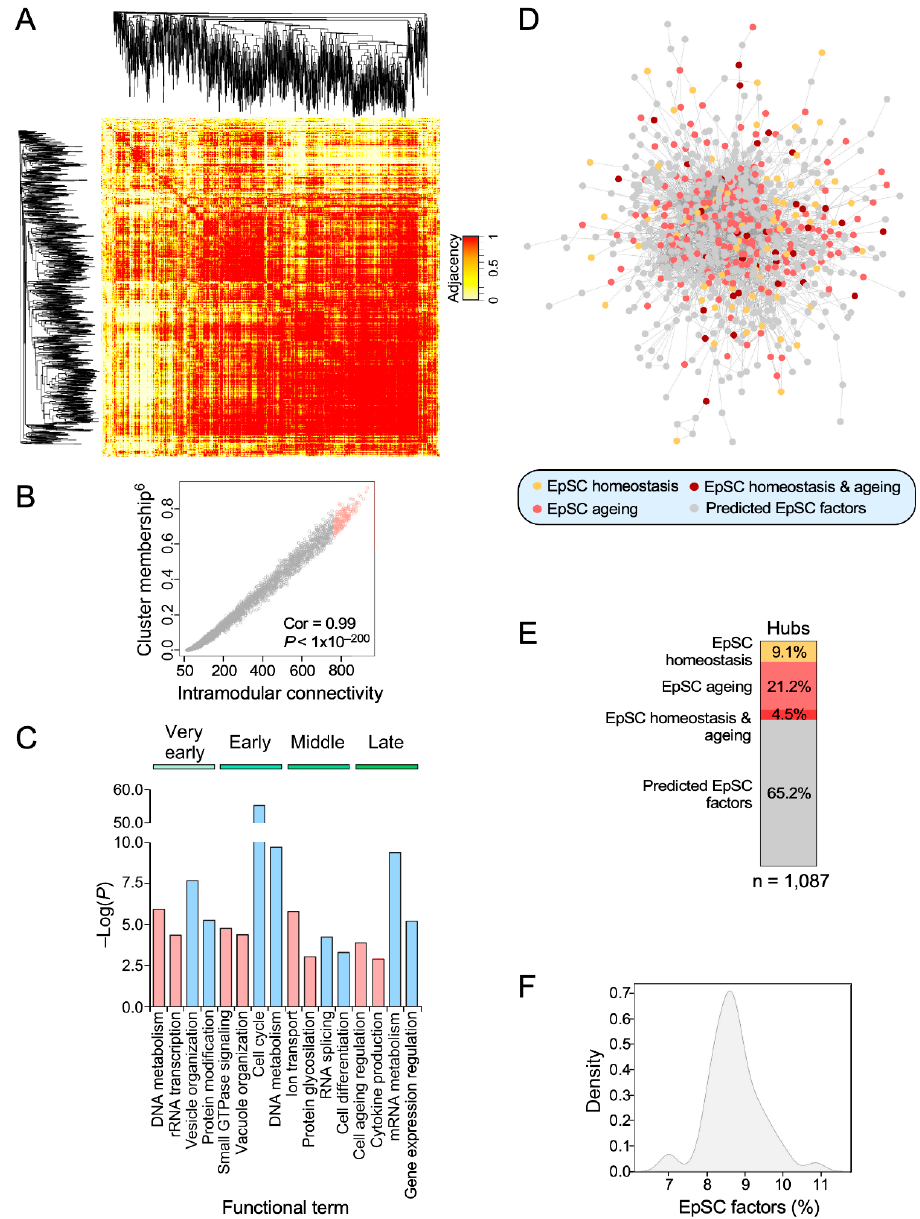
Figure 4. Identification of age-dependent mRNA-based hubs in SSCs. ( A ) Representative example of the adjacency heatmaps computed for each expression pattern using the WGCNA R package. Red areas indicate the presence of probesets that are highly correlated transcriptionally. Probeset clustering according to adjacency is depicted on the sides of the heatmap. ( B ) Representative example of a scatter plot showing the direct relationship between the cluster membership and the intramodular connectivity scores among the probesets within each expression pattern. The Pearson correlation coefficient with the corresponding p value is indicated. Identified hubs are highlighted in color. ( C ) Main functional terms derived from the gene ontology analysis of the identified hub genes for each expression pattern. Positive (“+”) and negative (“ − ”) enrichments against baseline are indicated. ( D ) Association network of the hubs identified in this study. Hubs that have not been previously associated with SSC homeostasis and/or ageing are indicated in gray color. ( E ) Percentage of the hubs identified in this study that have been associated with SSC homeostasis and/or ageing. Color coding is the same as in ( D ). ( F ) Density plot showing the percentage of genes associated to SSC homeostasis and/or ageing that are contained in random sets of 1087 genes ( n = 50).